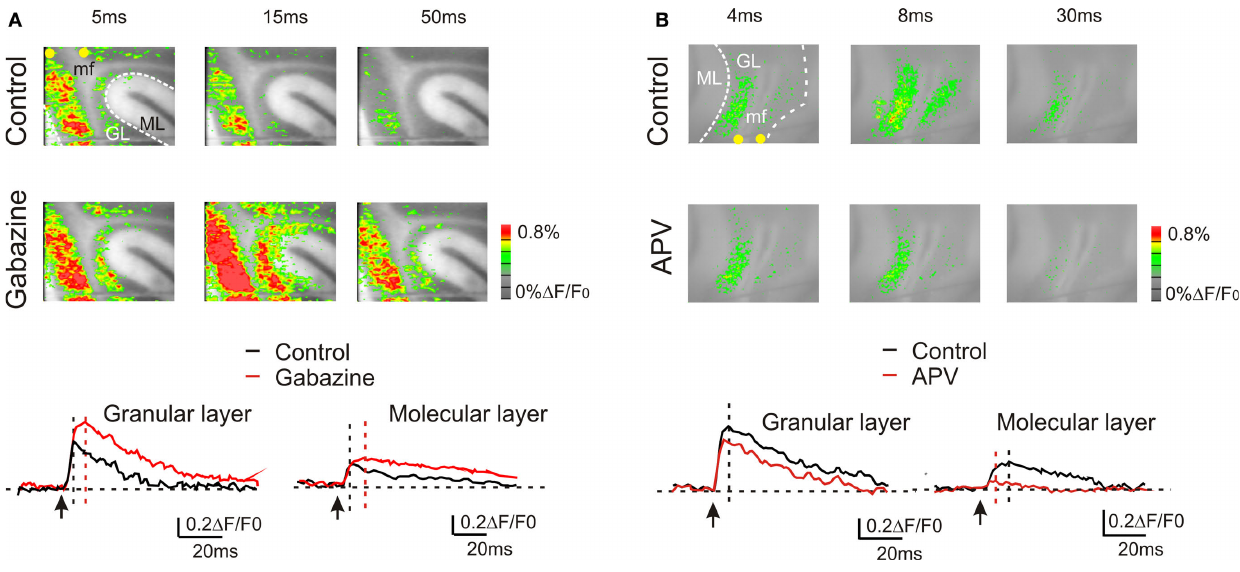
effect both in the granular and molecular layer. (B) The effect of the NMDA receptor blocker 50-μM APV in response to a single pulse in the white matter. APV reduced the granular layer response and markedly depressed transmission toward the molecular layer. The traces show the time course of the